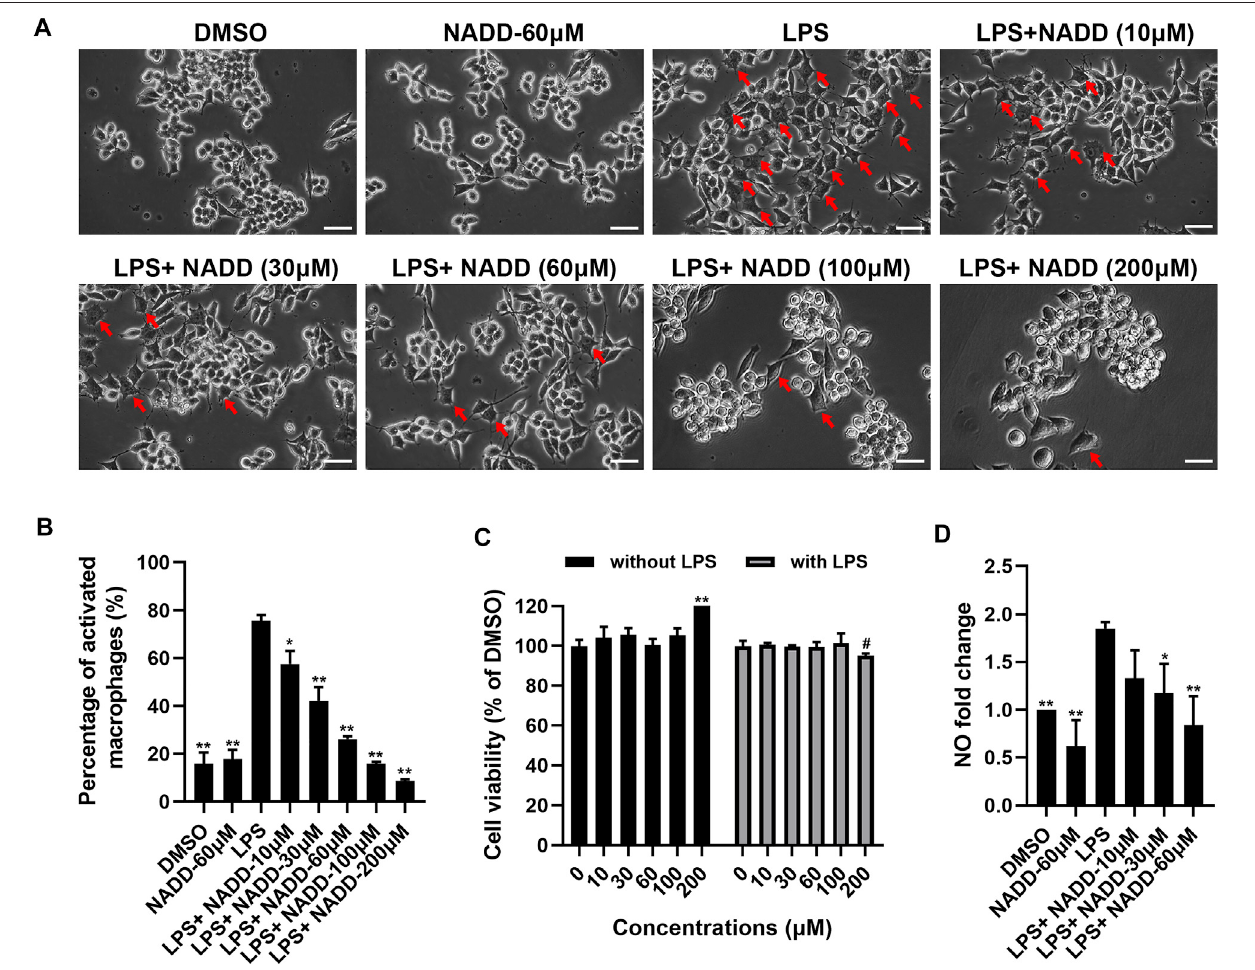
FIGURE 4 | The effect of NADD on LPS-induced in fl ammation in vitro . (A) The morphology of RAW264.7 macrophages treated with DMSO, NADD-60 μ M, LPS, LPS + NADD-10 μ M, LPS + NADD-30 μ M, LPS + NADD-60 μ M, LPS + NADD-100 μ M, and LPS + NADD-200 μ M. Red arrows indicate activated macrophages; white bar = 100 μ m. (B) The statistical analysis of morphologic changes of RAW264.7 macrophages treated with DMSO, NADD-60 μ M, LPS, LPS + NADD-10 μ M, LPS + NADD-30 μ M,LPS+NADD-60 μ M,LPS+NADD-100 μ M,andLPS+NADD-200 μ M.Differenceswerestatisticallysigni fi cantwhencomparedwiththeLPSgroup ( *p < 0.05, **p < 0.01). (C) Cell viability by CCK8; without LPS: RAW264.7 macrophages were not stimulated by LPS; with LPS: RAW264.7 macrophages were stimulated with LPS after cells were pre-treated with different concentrations of NADD. Differences were statistically signi fi cant when compared with the 0 μ M group ( **p < 0.01, without LPS; # p < 0.05, with LPS). (D) NO in culture supernatant from different groups of cells. Differences were statistically signi fi cant when compared with the LPS group ( *p < 0.05, **p <